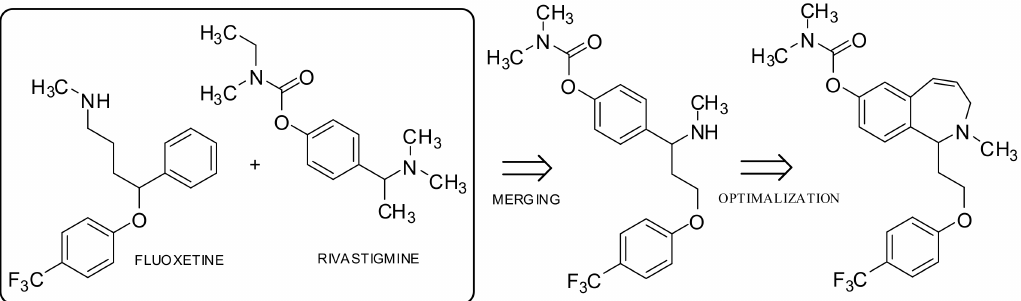
Figure 9. Rivastigmine-fluoxetine